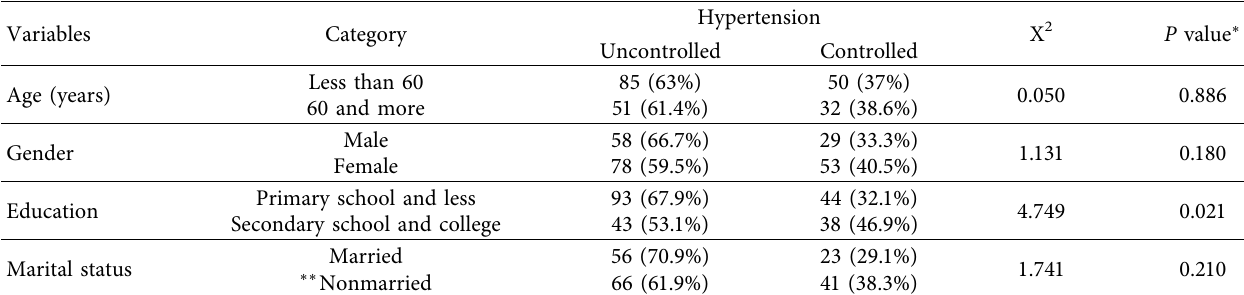
Table 3: Relationship of socio-demographic variables with HTN control applying the Chi-square